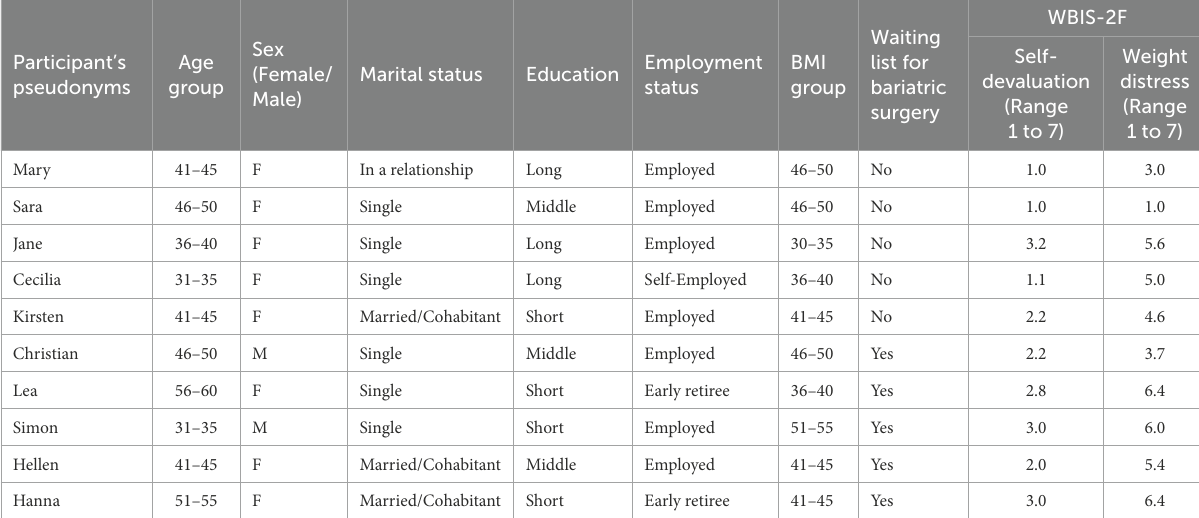
TABLE 1 Characteristics of